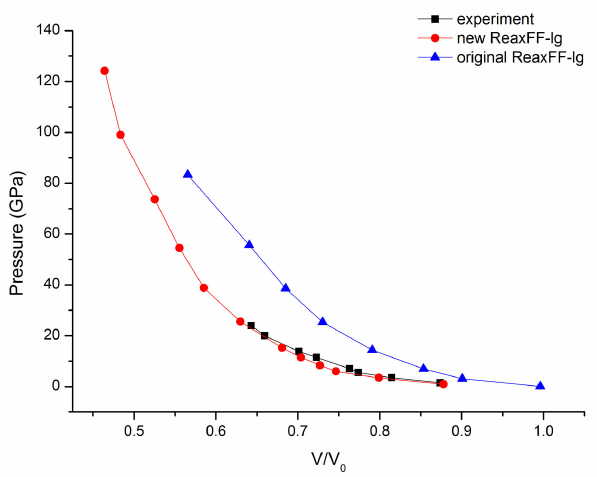
Figure 2. Comparisons of the compression equation of state for α